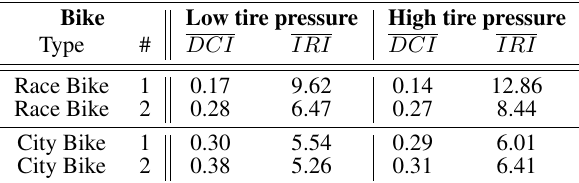
Table 1. Average DCI and IRI values of the four bikes with different tire pressures.